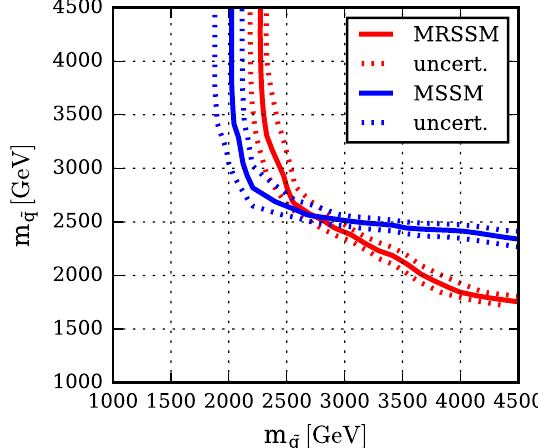
Figure 2 . Mass limits on squarks and gluinos in case of degenerate 1st and 2nd generation squarks. The limits are based on a recasting of LHC analyses, and the marked bands correspond to the theory uncertainty of the cross sections (see discussion in section